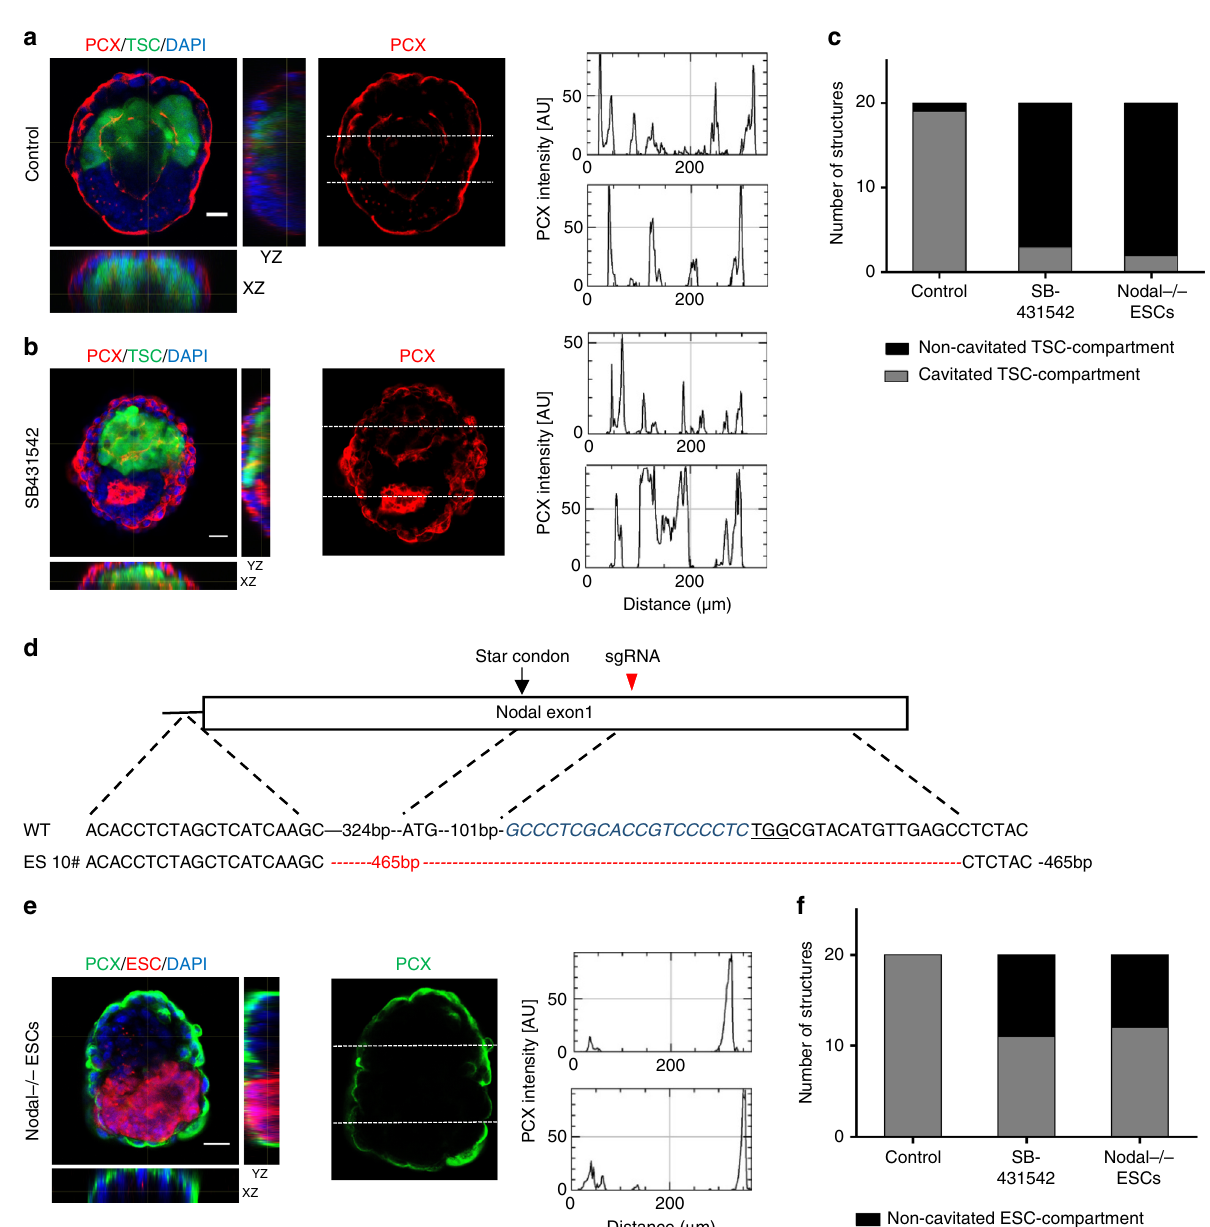
Fig. 4 Inhibition of Nodal signaling affects cavitation of the TSC compartments in ETX-embryoids. a , b ETX-embryoids culutred in control condition and in 10 μ M SB431542 for 84 h, respectively. PCX staining (red) highlight cavity formation in both ESC- and TSC compartments (left panel), and fl uorescence traces is of PCX intensity along region indicated by the dotted lines in the ESC- and TSC compartments (right panel). Orthogonal xz and yz views are shown. n = 20 ETX-embryoids per group. c Quanti fi cation show the number of ETX-embryoids with cavitated TSC compartments after 72 h in culture in control, SB431542 and Nodal – / – ESC conditions. n = 20 ETX-embryoids per group. d Schematic diagram of gene editing at the Nodal loci. Wild-type sequence is shown at the top of the targeting sequence. sgRNA sequences are shown in blue. Protospacer adjacent moti (PAM) sequences are underlined. Deletions are highlighted in red. WT: wild-type; deletion “ − ” . e ETX-embryoids assembled from Nodal -/- ESCs for 84 h. PCX staining (green) indicates no cavity formation in both ESC- and TSC compartments (left panel), and fl uorescence trace is of PCX intensity along region indicated by the dotted lines in the ESC- and TSC compartments (right panel). f Quanti fi cation of ETX-embryoids with cavitated ESC compartments after 72 h in culture in control, SB431542 and Nodal -/- ESC conditions. n = 20 ETX-embryoids per group. Scale bar, 20 µ m ( a , b , e ). Experiments were repeated at least two times with similar results. Source data of c and f are provided as the Source Data fi